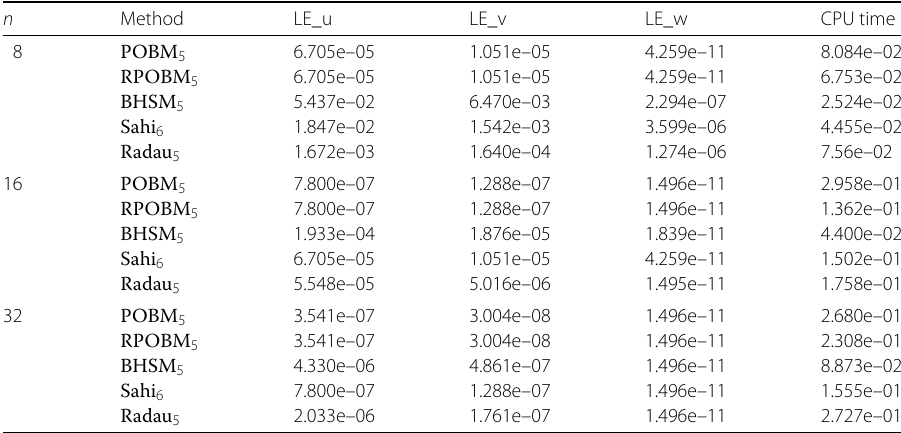
Table 5 Comparison of absolute errors at x = 10 for the Blasius equation of boundary layer flow given in Problem 5 with different number of steps ( n